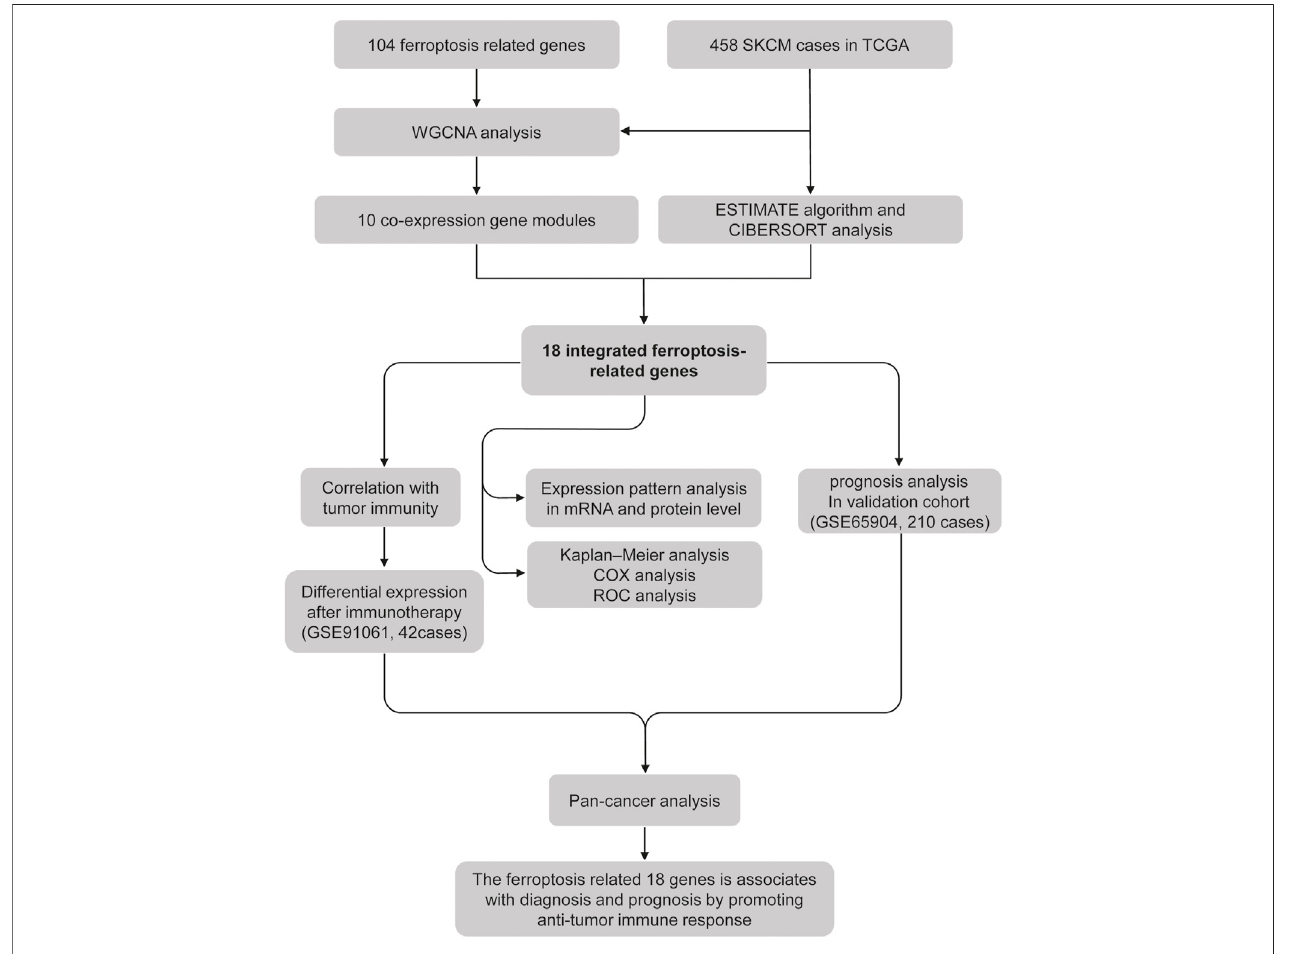
FIGURE 1 | Flowchart of the